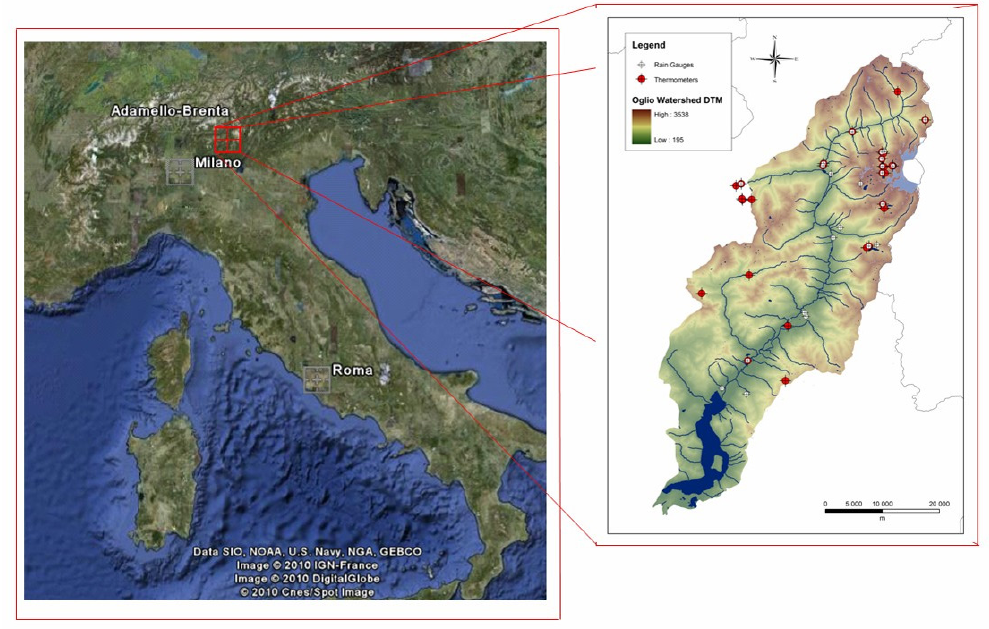
Fig. 1. The study area: Oglio river basin in the Italian Alps. Red dots are rain gage network. Blue dots are available thermometers.